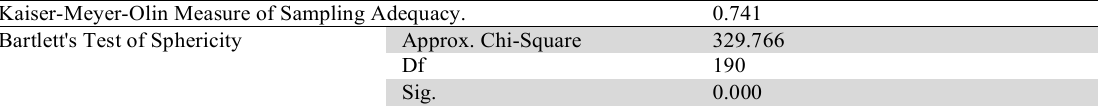
KMO and Bartlett's Test Kaiser-Meyer-Olin Measure of Sampling Adequacy.